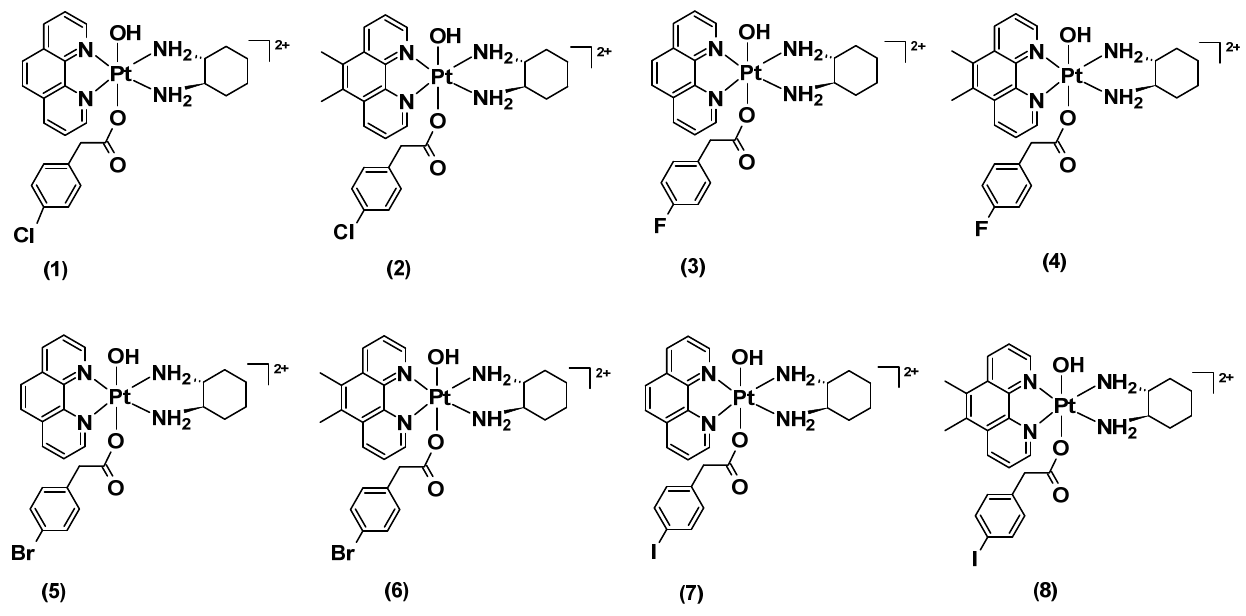
Figure 6. Chemical structures of the studied platinum(IV) complexes ( 1 – 8 ), incorporating the halo- genated PAA derivatives, 4-CPA, 4-FPA, 4-BPA, and 4-IPA. Counter-ions were omitted for clarity.